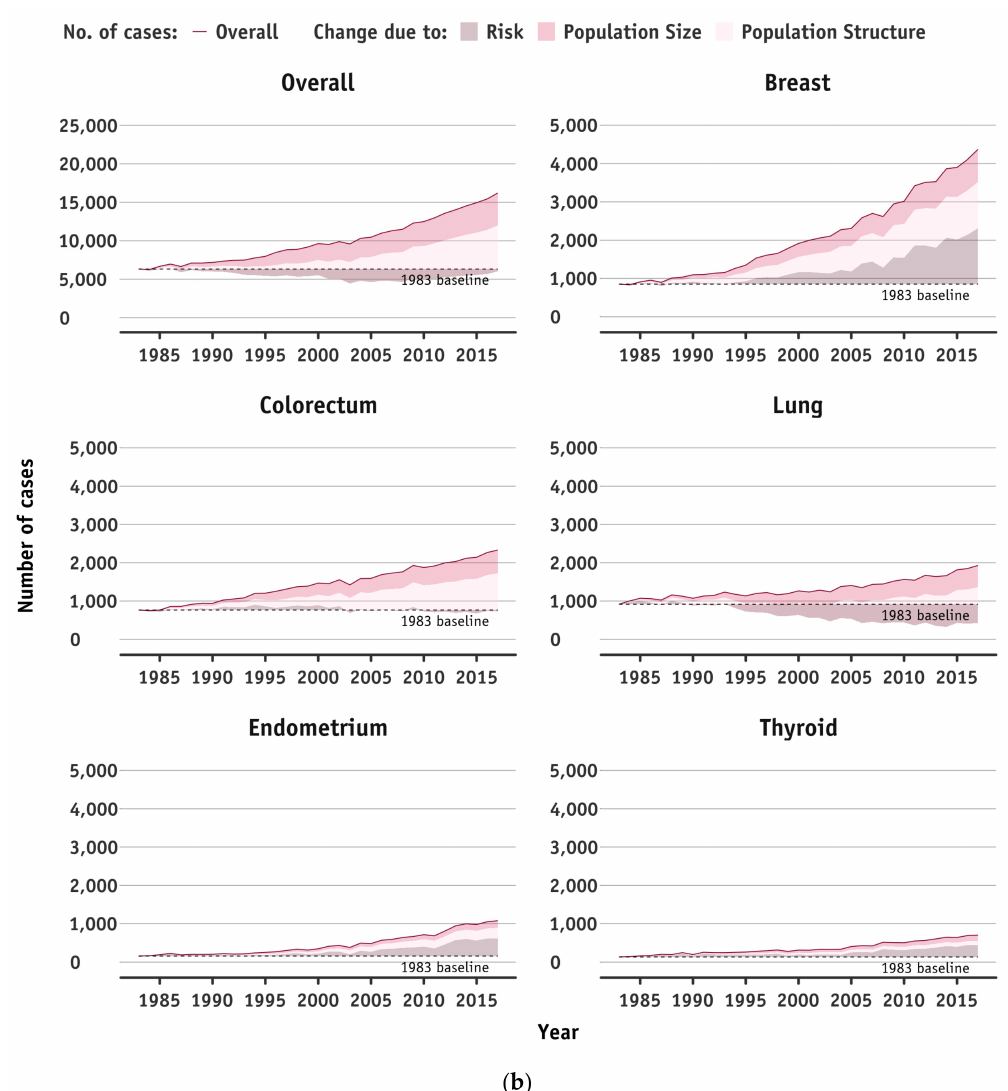
Figure 2. ( a ) Trends in number of incident cases for all cancer sites combined and top five cancers (ranked by 2017 figures) attributed to changes in disease risks and diagnostic practices (i.e., epidemiological components), and population size and structure (i.e., demographic components) for men in Hong Kong from 1983 to 2017. The solid line represents the overall number of incident cases, while the shaded areas represent the change in incident cases (compared to the 1983 baseline, dashed line) due to risk, population structure, and population size. ( b ) Trends in number of incident cases for all cancer sites combined and top five cancers (ranked by 2017 figures) attributed to changes in disease risks and diagnostic practices (i.e., epidemiological components), and population size and structure (i.e., demographic components) for women in Hong Kong from 1983 to 2017. The solid line represents the overall number of incident cases, while the shaded areas represent the change in incident cases (compared to the 1983 baseline, dashed line) due to risk, population structure, and population